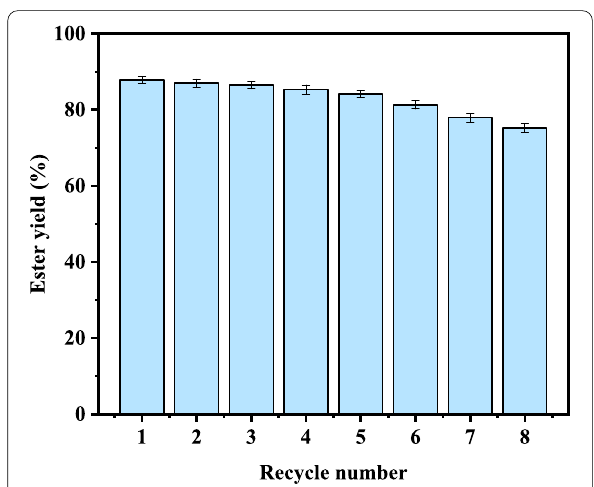
Fig.4 Effects of repeated use of Novozym 435 on LBE